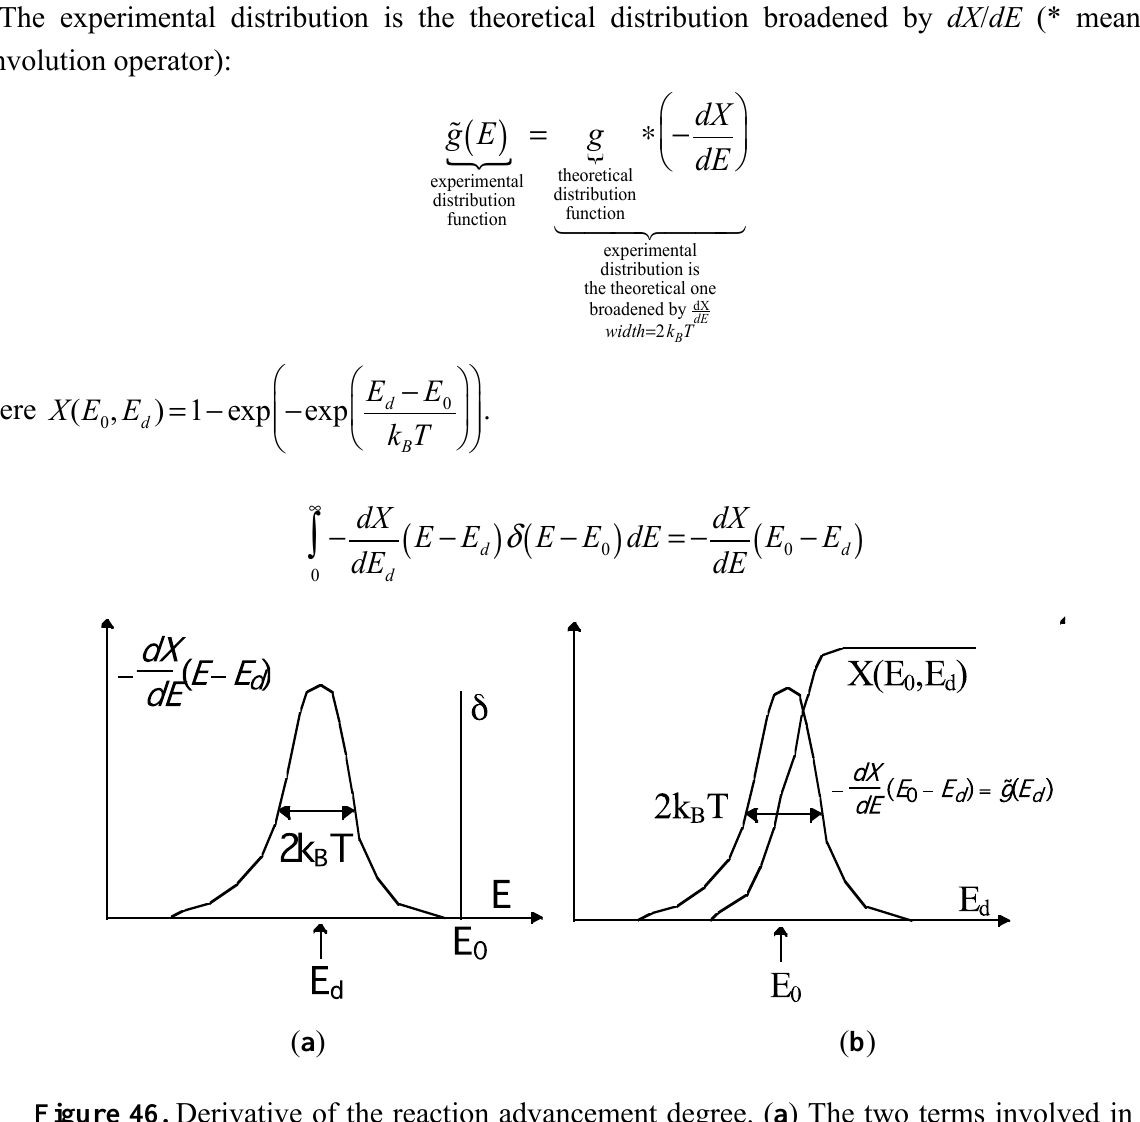
Figure 46. Derivative of the reaction advancement degree. ( a ) The two terms involved in the convolution; ( b ) the experimental